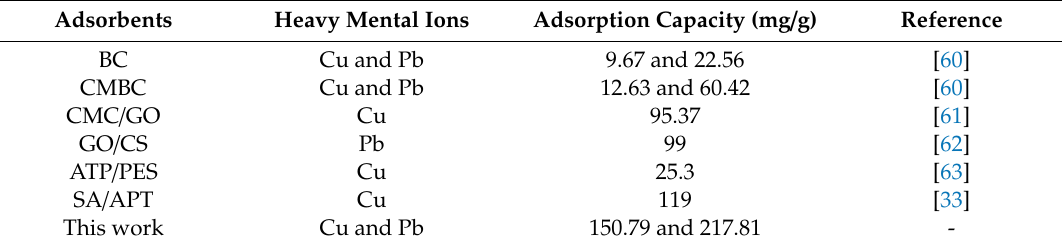
Table 3. Maximum adsorption capacity of heavy metal ions on some